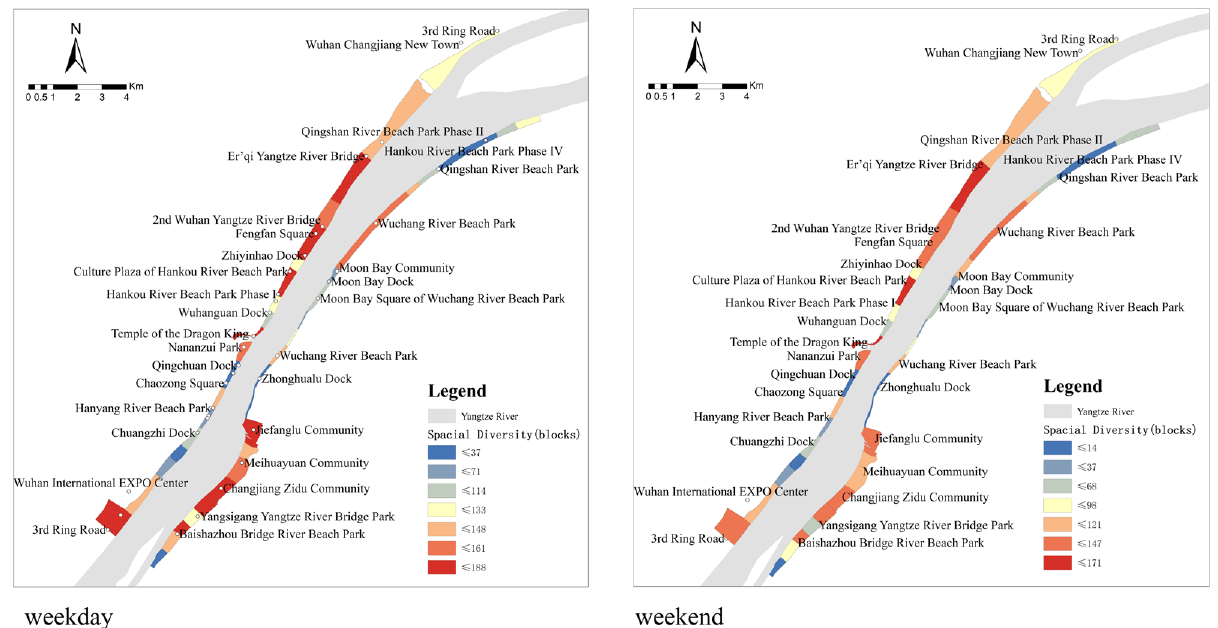
11 of 22 Figure 5. The space distance distribution of the riverside area of Wuhan. In general, the distribution of spatial distance in the waterfront area of Wuhan pre- sented regional aggregation characteristics; waterway transportation hubs had the high- est spatial distance value, and people were willing to come to the landscape parks and cultural spots in the riverside area from farther places for activities on the weekends. 4.1.3. Space Diversity The space diversity indicator presents the number of user origins, indicating the abil- ity of a research unit to attract people from different regions. As shown in Figure 6, the distribution pattern of the units with high spatial diversity in the Wuhan riverside showed regional aggregation characteristics, indicating that the units were mainly distributed in the research units where high-quality landscape parks and residential areas such as the Er’qi Yangtze River Bridge, Fengfan Square, the Culture Plaza of Hankou River Beach Park, and the Temple of the Dragon King are located. Overall, the space diversity during